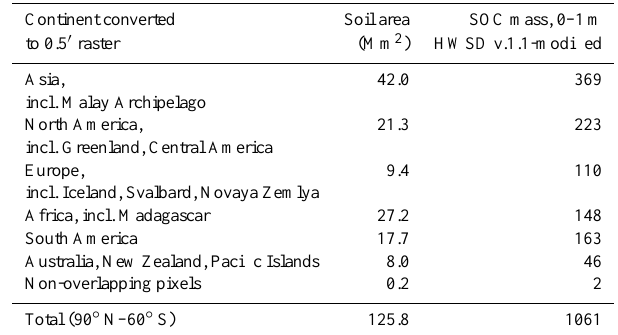
Table 3. Soil organic carbon masses by continent. For the definition of “continents” we used the ESRI (2002) map of continents with coastlines extended by two pixels to increase the overlap. 1Mm 2 = 10 6 km 2 . Continent converted Soil area SOC mass, 0–1m to 0.5 (cid:48) raster (Mm 2 ) HWSD v.1.1-modified Asia, 42.0 incl. Malay Archipelago